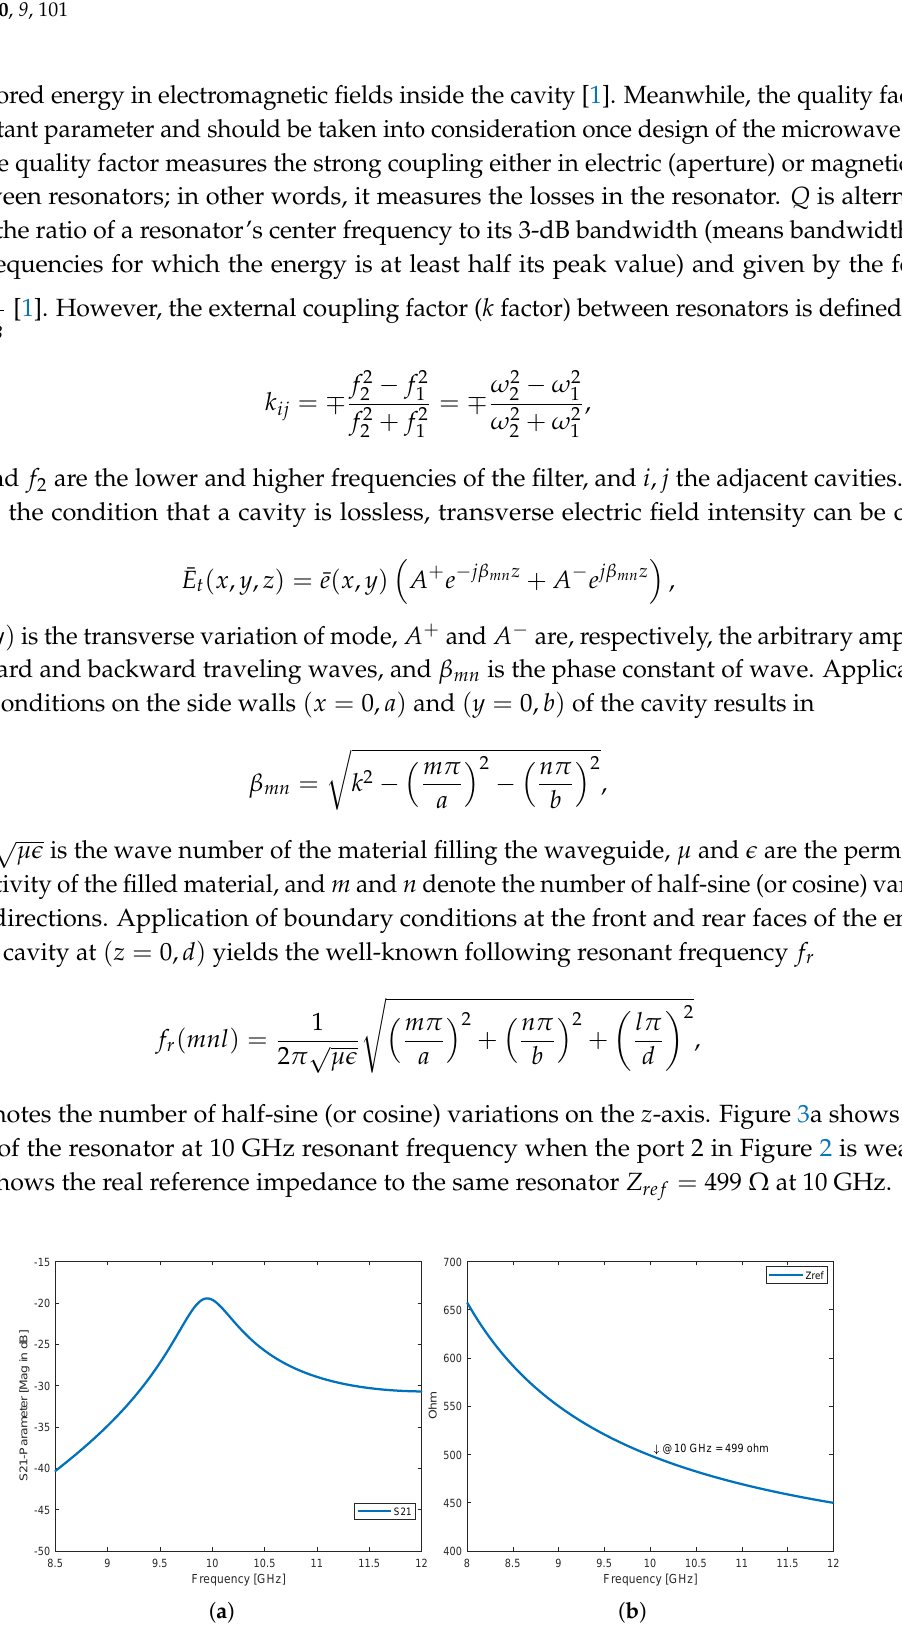
Figure 3. ( a ) S21 parameter of waveguide resonator, and ( b ) reference Impedance real part of waveguide